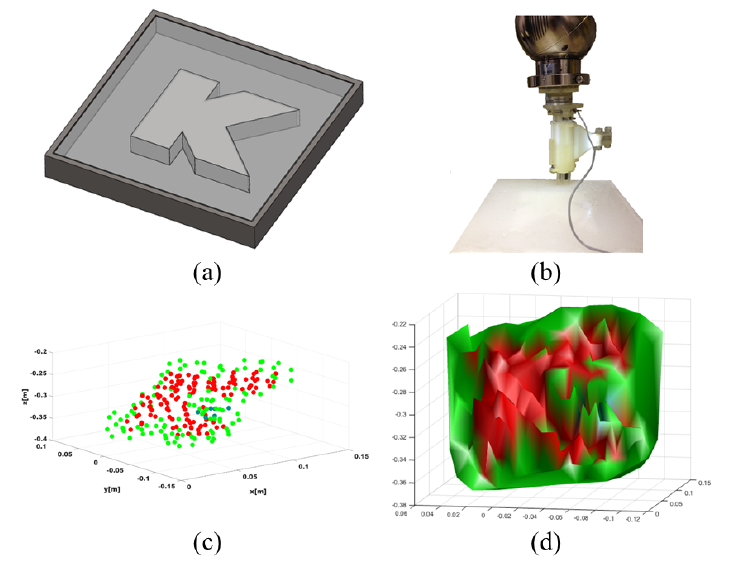
Figure 7. Computation of the stiffness map: CAD model of the phantom mould ( a ); Experimental setup ( b ); Post-processed map and generated surface are shown in ( c , d ). The stiffness of the track (red) is successfully distinguished from the surrounding silicone